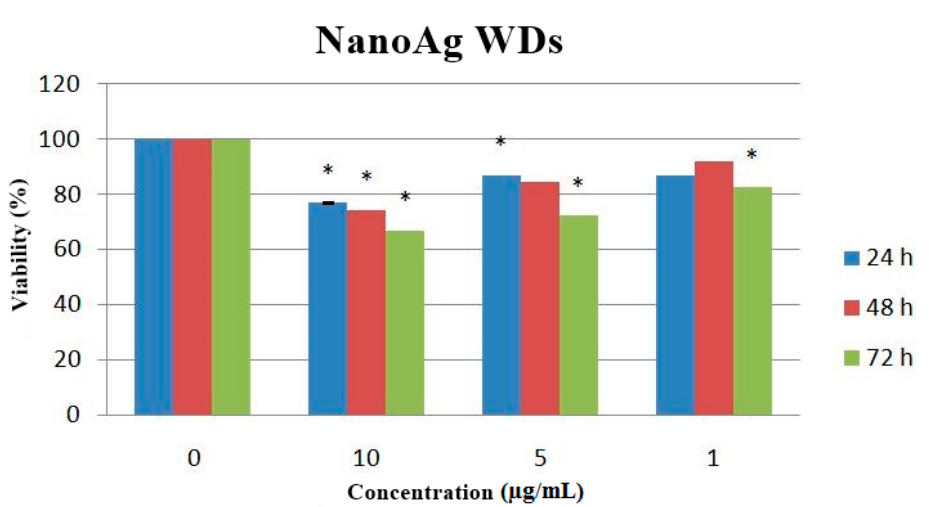
Figure 7. Cell viability depending on AgNPs concentration.* p < 0.05.